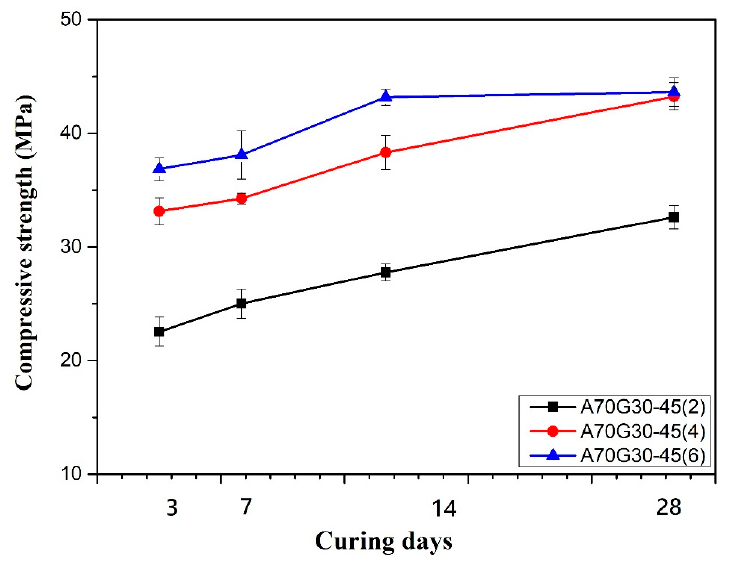
Figure 6. Effect of NaOH concentration on the compressive strength of AG-73 geopolymer.